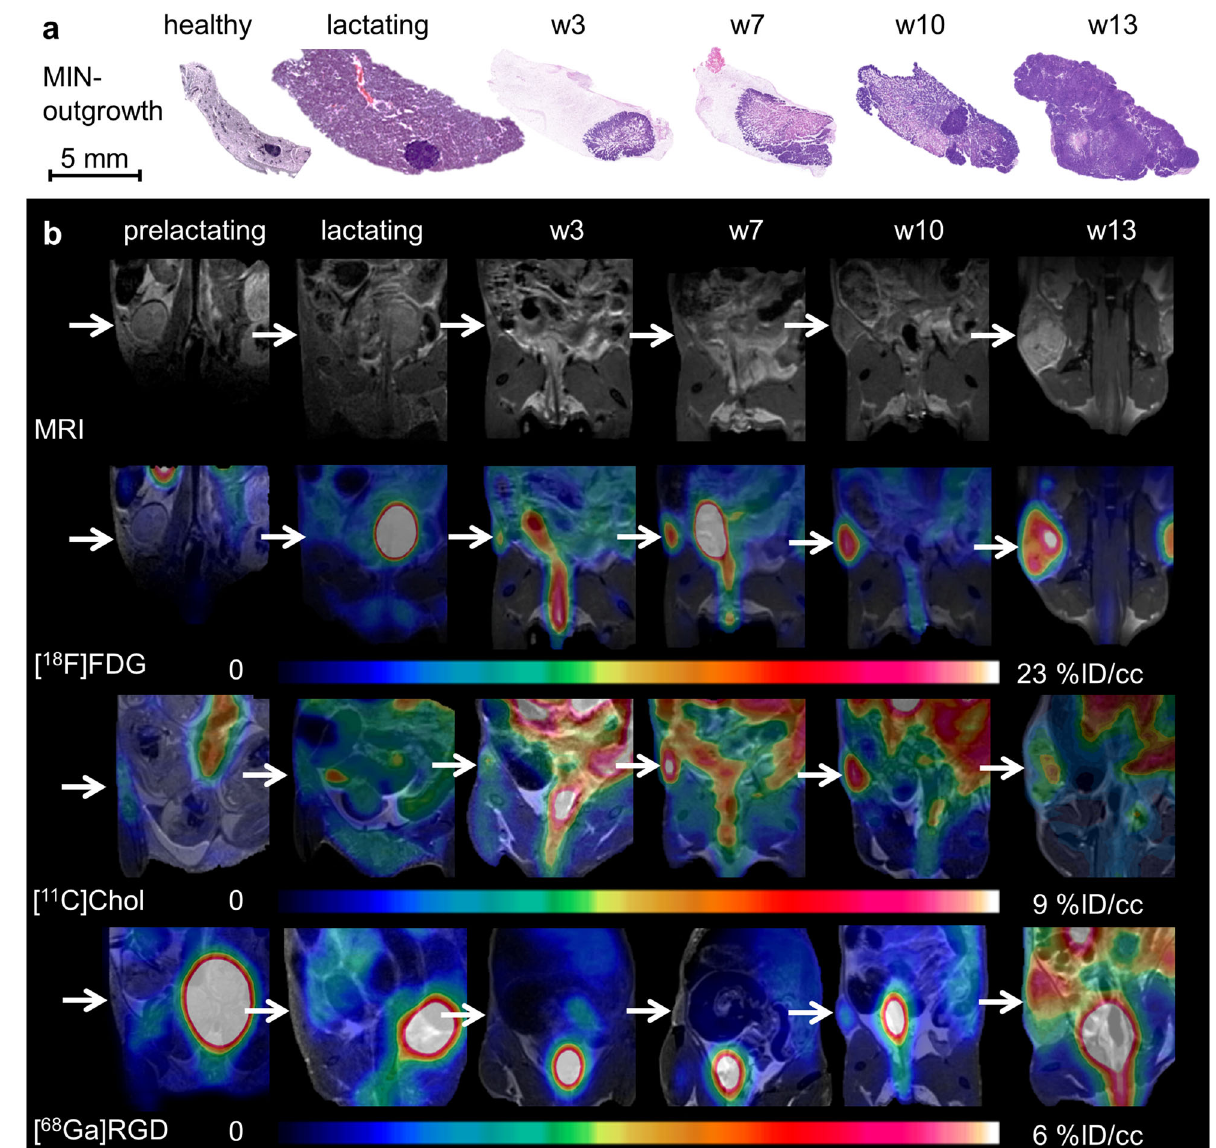
Fig. 2 Tracer accumulation during tumorigenesis of the MIN-O model compared to prelactating and lactating mammary glands. a H&E histology slides illustrating the development of the MIN-O lesions within the mammary glands compared to controls of a healthy and lactating gland. b Anatomical MRI and fused PET/MR images of a representative MIN-O mouse over time compared to pre- and lactating glands for the investigated tracers [ 18 F]FDG, [ 11 C]Chol and [ 68 Ga]RGD (white arrows indicate the region of the glands and MIN-O, respectively), and tracer uptake of all tracers increased during tumorigenesis over time.